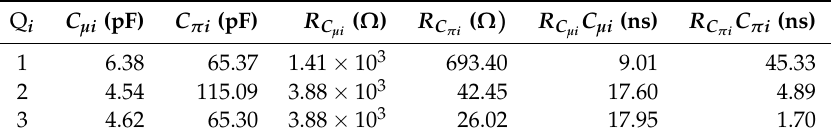
Table 2. RC time constants for the second